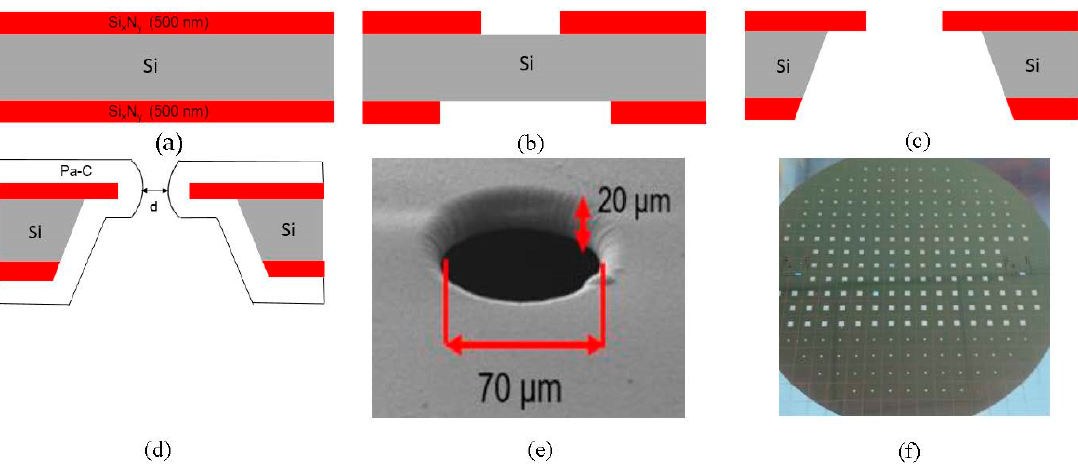
Figure 1. ( a – d ) Fabrication processes of micro apertures on silicon nitride membranes where a 380 µm double sided polished silicon wafer was used as base substrate; ( e ) Parylene-C coated aperture (70 µm diameter); ( f ) finalized wafer after dicing (chip dimension 5 × 5 mm 2